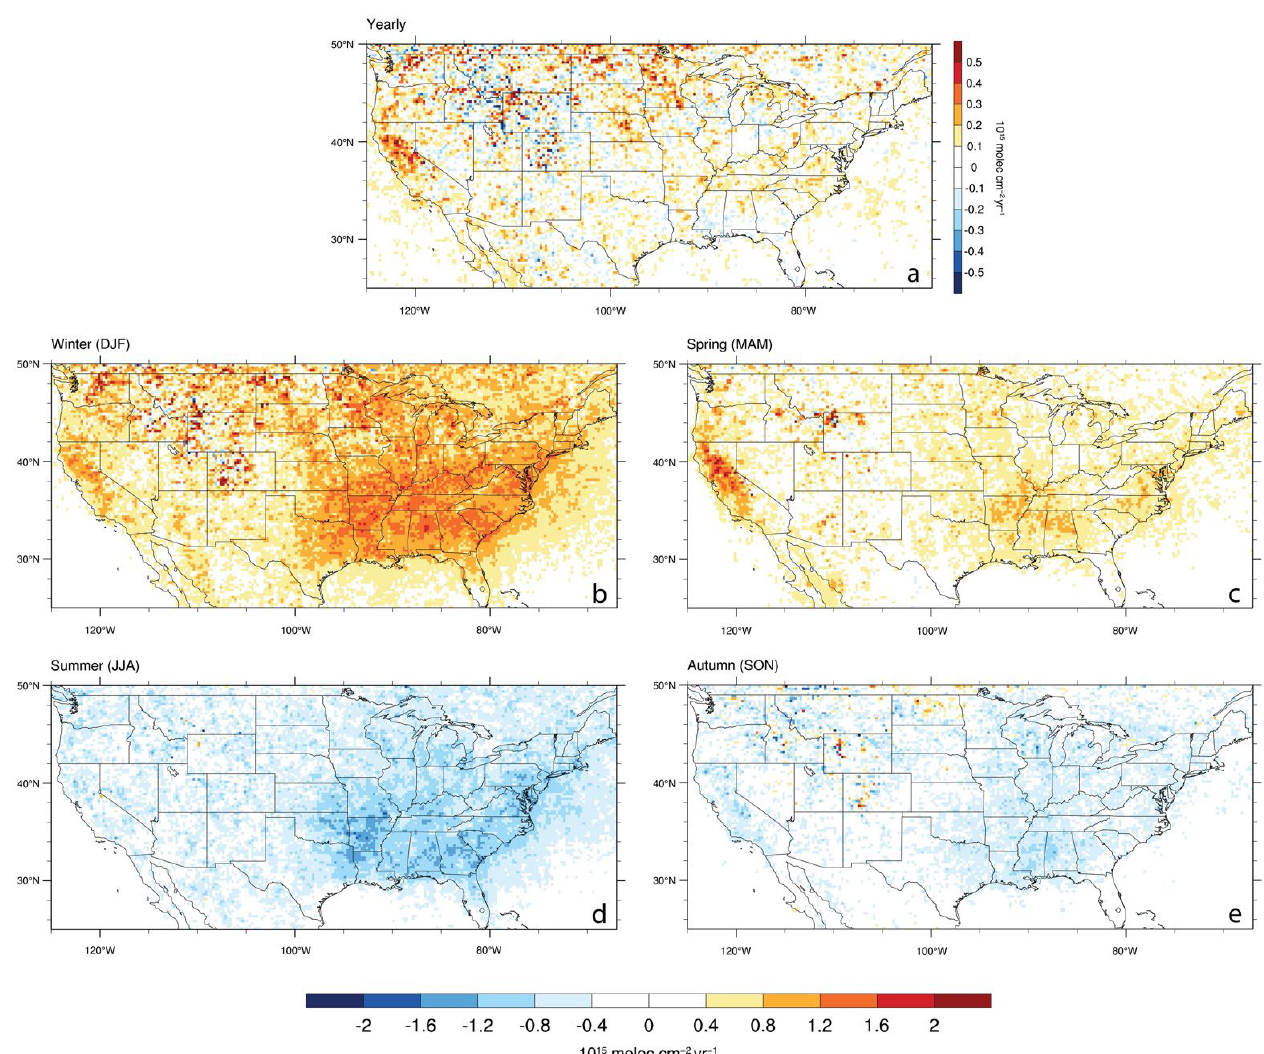
Figure 6. Map of the U.S. with 2006–2015 OMI HCHO trend in ( a ) all seasons, ( b ) winter, ( c ) spring, ( d ) summer, and ( e ) autumn.